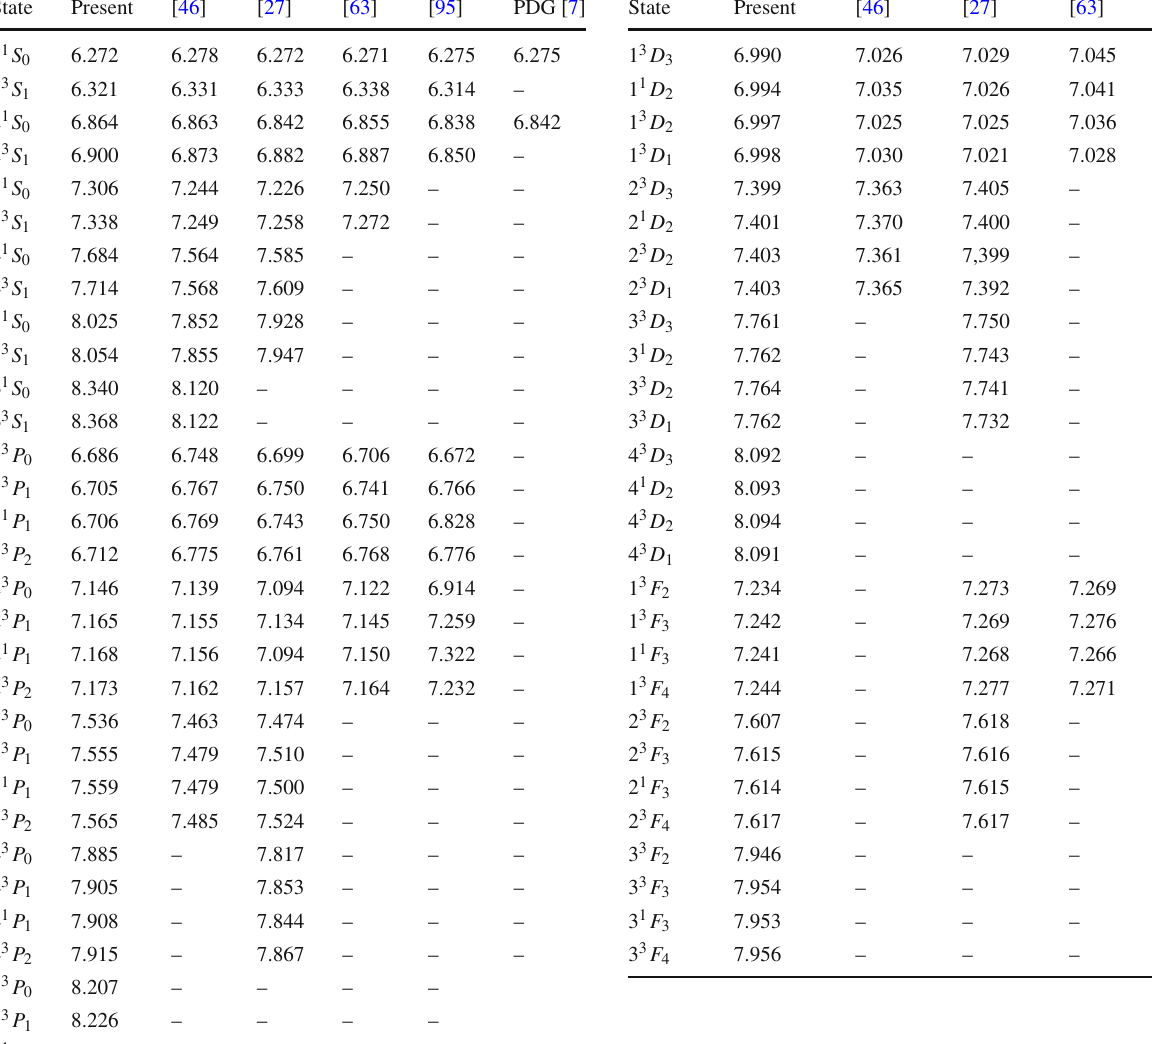
Table 6 Mass spectrum of S and P -wave B c meson (in GeV) State